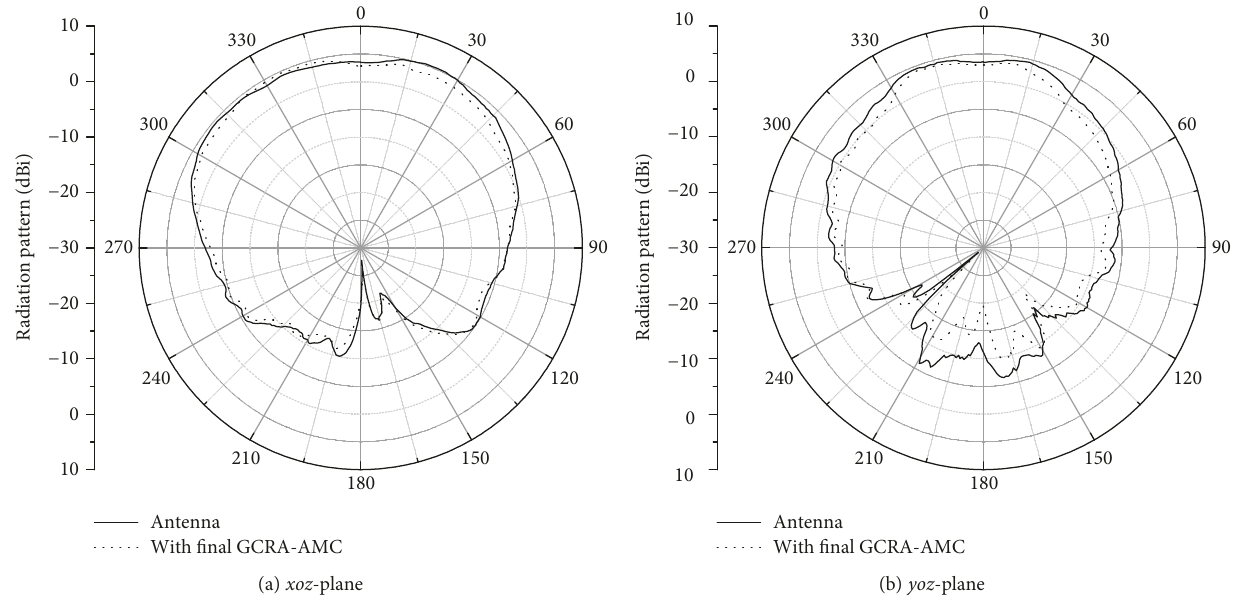
Figure 12: The radiation patterns of the microstrip antenna with and without fi nal GCRA-AMC.